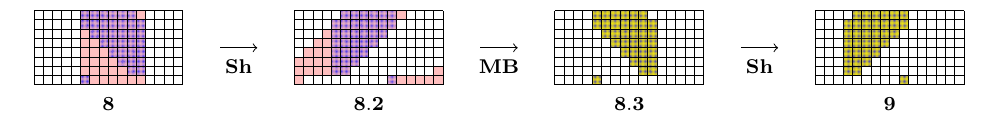
Figure 10: Fitting the two pieces, second